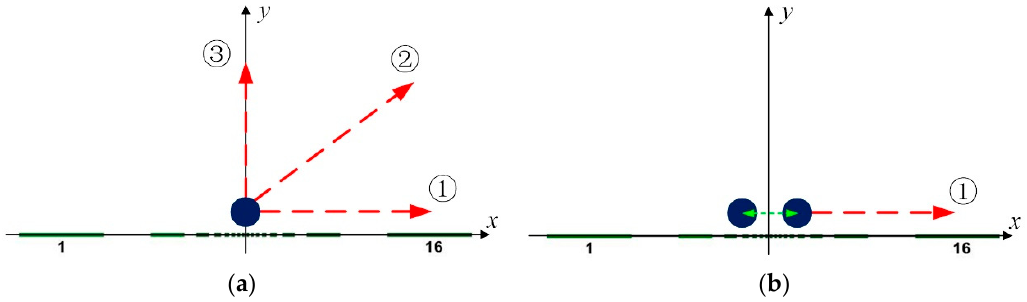
Figure 8. Traces of inclusions involved in dynamic tests: ( a ) single inclusion; ( b ) double